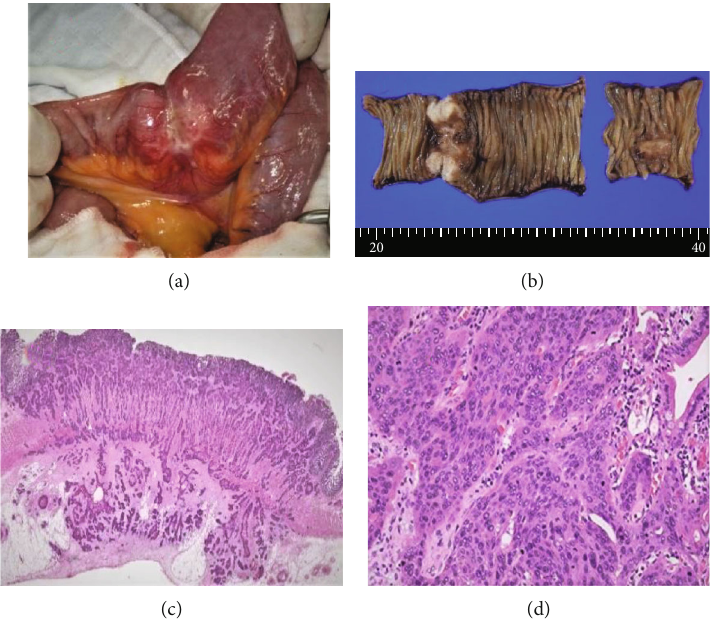
Figure 3: Metastatic tumors from esophageal carcinoma in the small intestine. (a) Gross fi nding at surgery. The metastatic tumor obstructed the small intestine. (b) Gross appearance of the resected small intestine. Two metastatic tumors were present. The left specimen showed circumferential stenosis in the jejunum. (c) Histologic fi nding of the metastatic tumor in the jejunum. HE stains showed moderately di ff erentiated squamous cell carcinoma. (d) High magni fi cation view. Moderately di ff erentiated squamous cell carcinoma growing in a trabecular pattern. The pathological features were consistent with the diagnosis of esophageal cancer